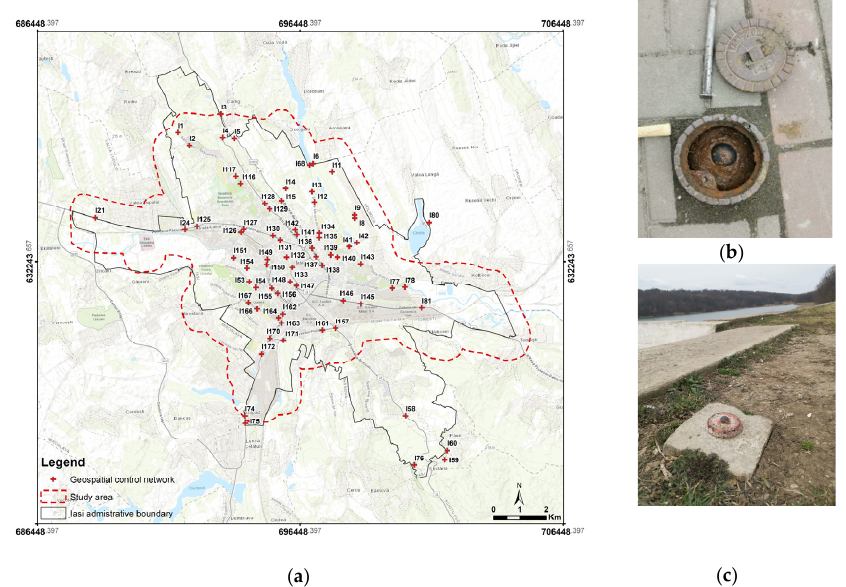
Figure 7. ( a ) Geospatial control network of 71 leveling points; ( b ) metallic survey markers; ( c ) concrete survey markers.